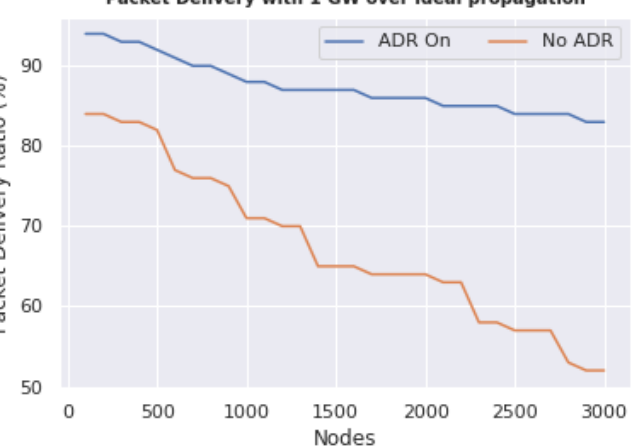
Figure 10. Packet delivery ratio to the network server with a single gateway under ideal propaga- tion